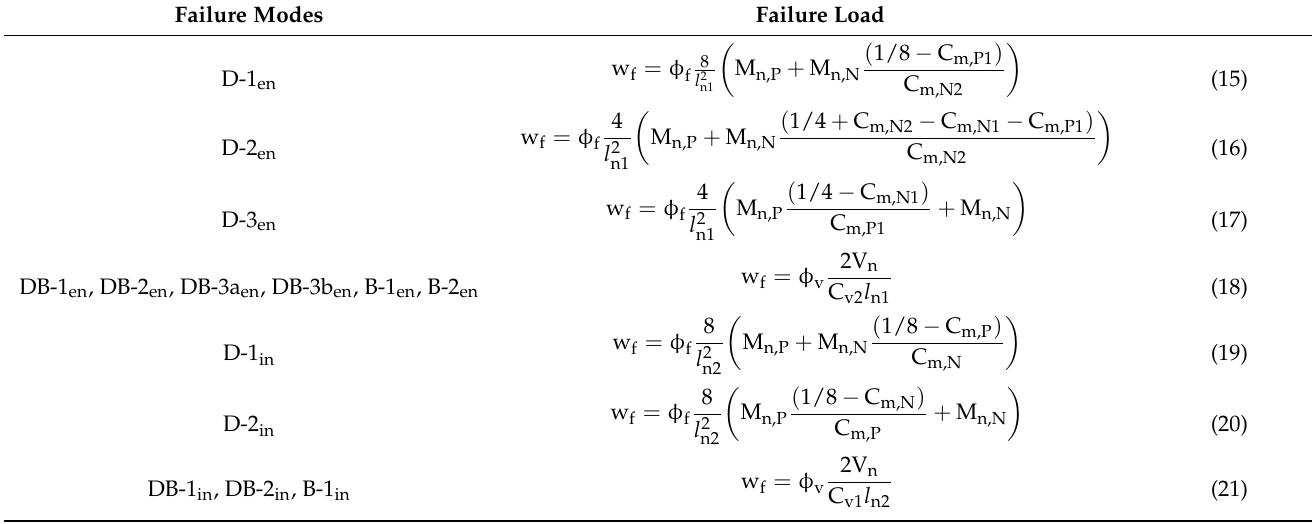
Table 2. Calculating ultimate failure loads of continuous RC